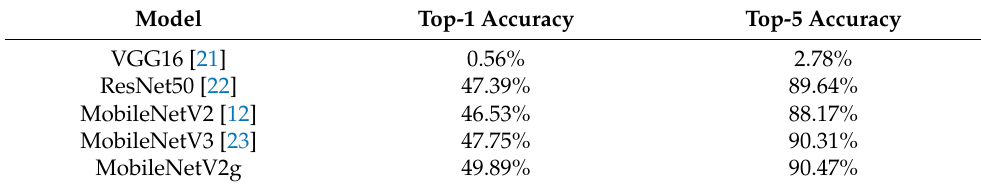
Table 3. Accuracies of different